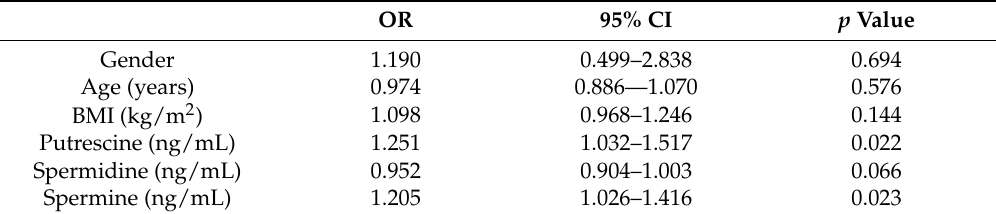
Table 5. Multiple logistic regression analysis: risk of T2D, adjusted for gender, age, BMI, and serum polyamine levels.